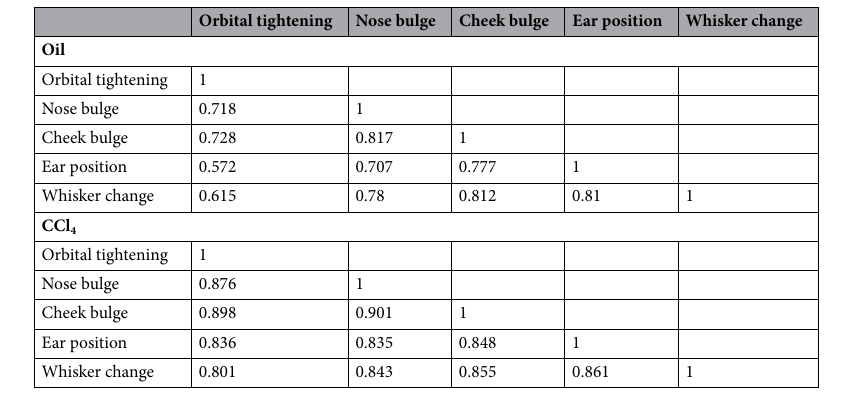
Table 1. Time- and intervention-independent correlations of the grimace scale